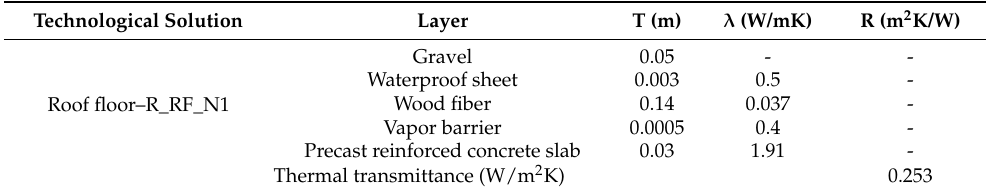
Table A27. Possible redevelopment measure for roof floor with gravel as the finishing layer (R_RF_N1).